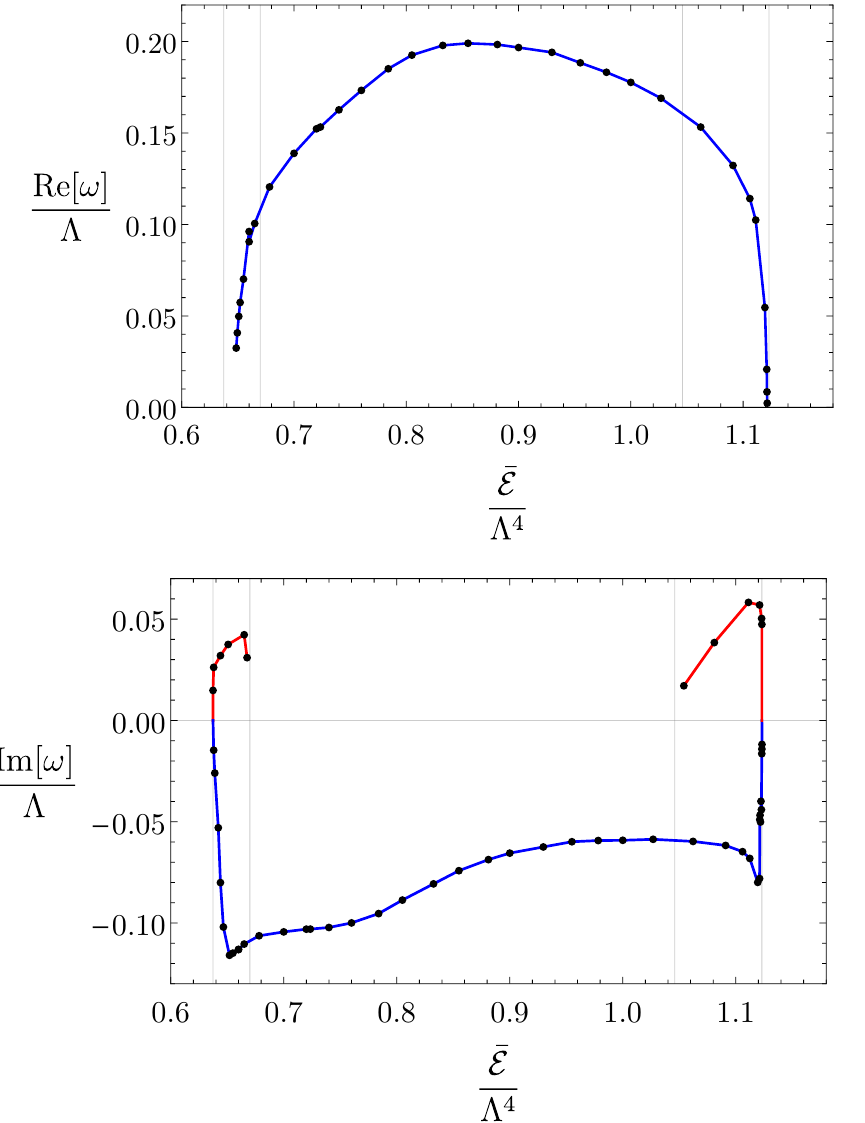
Figure 26 . Real part (top) and imaginary part (bottom) of the frequency of the dominant linear mode of the perturbations around static inhomogeneous solutions with ˆ L ’ 11 . 501849 and varying energy densities. The real part of omega goes to zero at the cusps and vanishes for locally unstable solutions. The imaginary part of omega goes to zero at the cusps and at the mergers. Vertical lines indicate the location of the mergers and the cusps, as in figure 22. Blue (red) curves correspond to locally stable (unstable)